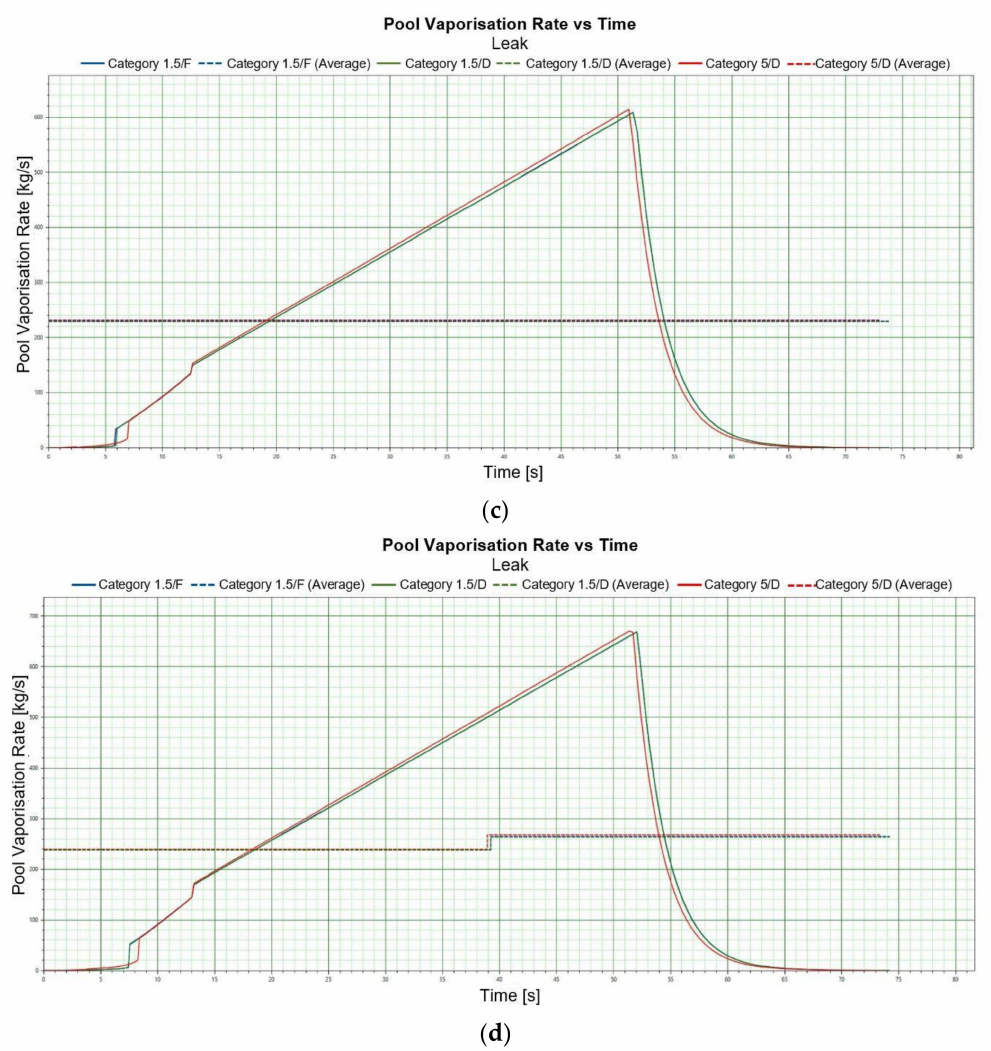
Figure 4. ( a ). Pool radius vs. time, LNG-Light 1 m, winter. ( b ). Pool radius vs. time, LNG-Heavy 1 m, summer. ( c ). Pool vaporisation rate vs. time, LNG-Light 1 m, winter. ( d ). Pool vaporisation rate vs. time, LNG-Heavy 1 m,